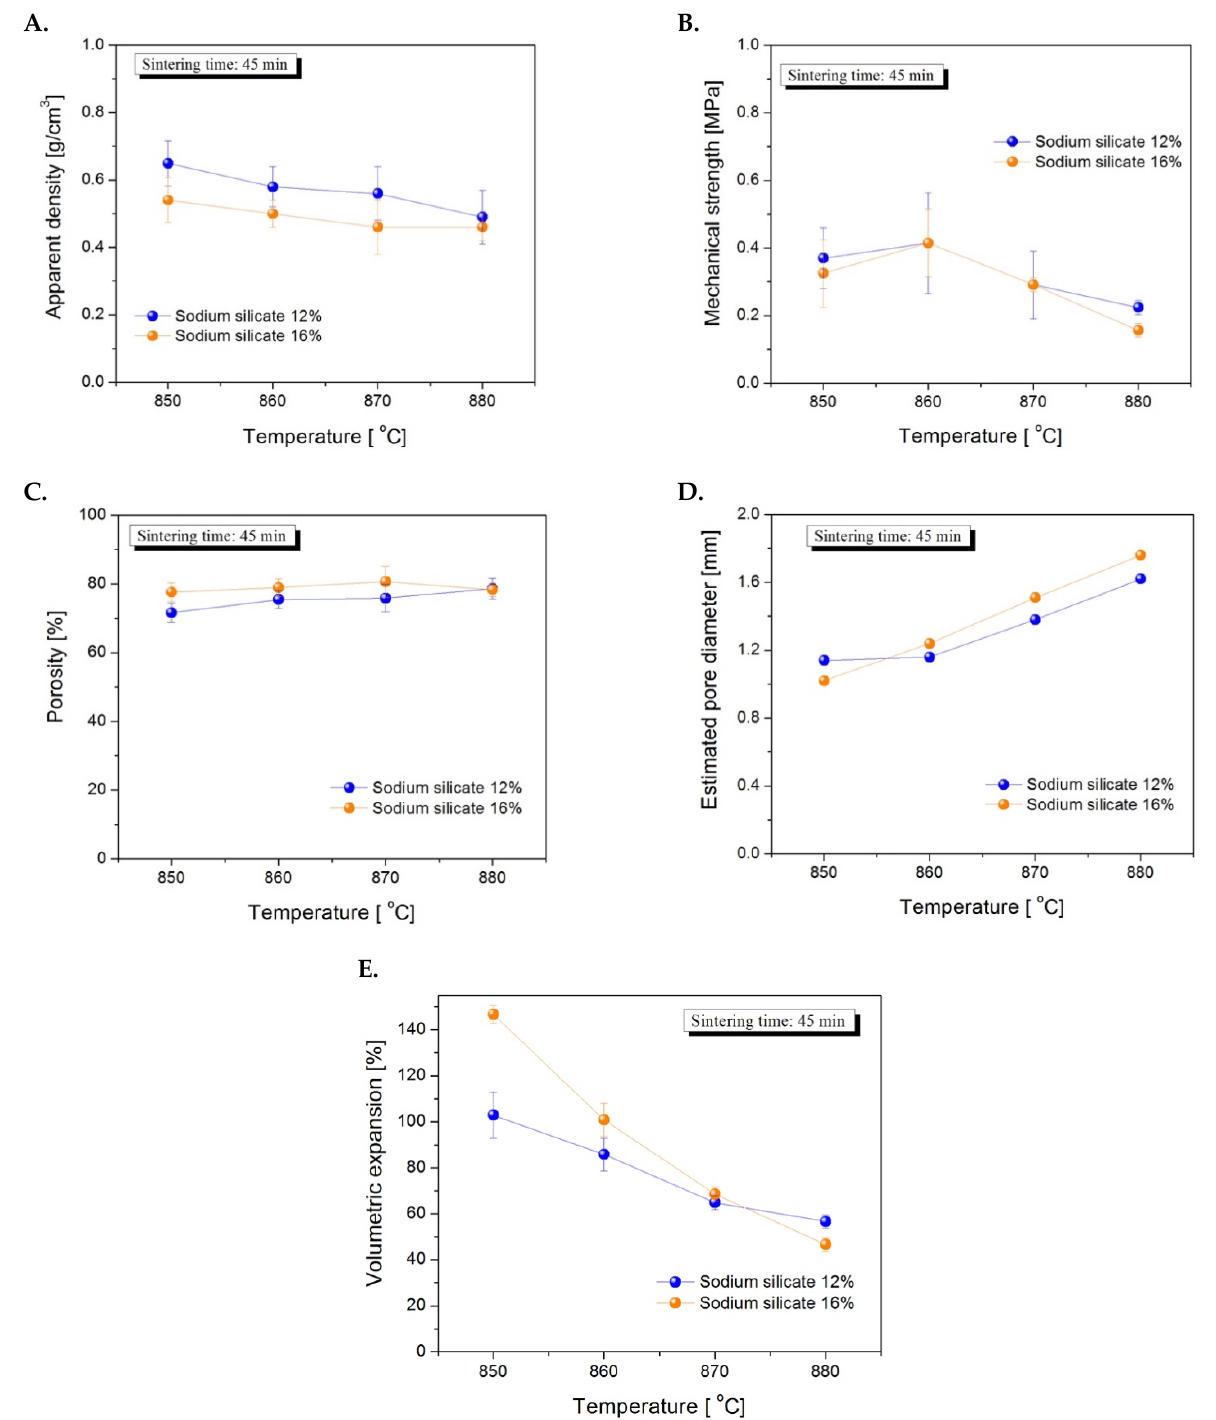
Figure 10. Effect of the sintering temperature on the characteristics of the ceramic foams obtained at a sintering time of 45 min: apparent density ( A ), mechanical strength ( B ), porosity ( C ), pore diameter ( D ) and volumetric expansion ( E ).